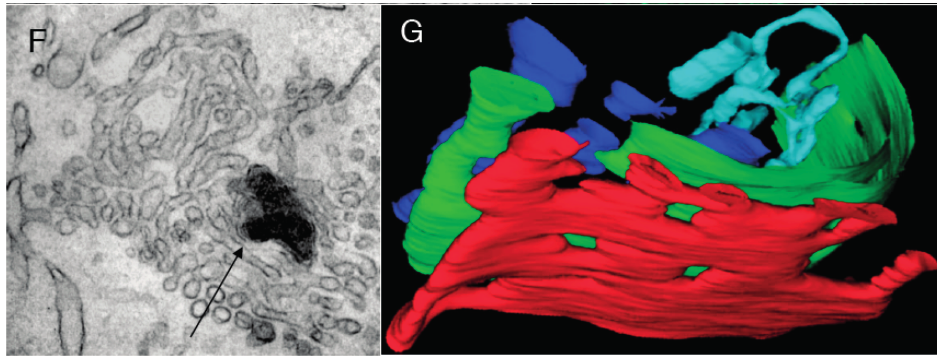
Figure 3. Control experiments. ( A ) Control HeLe cells labeled with an anti-tubulin antibody; ( B ) Cells treated with NZ; ( C ) Preservation of Golgi complex morphology in HeLa cells after 5 min NZ treatment; ( D , E ) BFA was added for 5 min after an irrelevant IgG ( D ) or the mutant of α SNAP ( α SNAPmu; E ) microinjection. Mannosidase II (ManII; red) did not redistribute into the endoplasmic reticulum, although most of the β -subunit of coatomer I (green) detached from the Golgi and diffusely labeled the cytosol; the Golgi stack was preserved; ( F ) Tubulated Golgi membranes after loading of cells with the WGA lectin conjugated with horse-radish peroxidase. The endosomal TGN is stained with OsO 4 (arrow); ( G ) Three-dimensional tomogram reconstruction of an isolated Golgi stack. Bars: 10 µm ( A , B ); 150 nm ( C , D ); 5 µm ( E ); 100 nm ( F , G